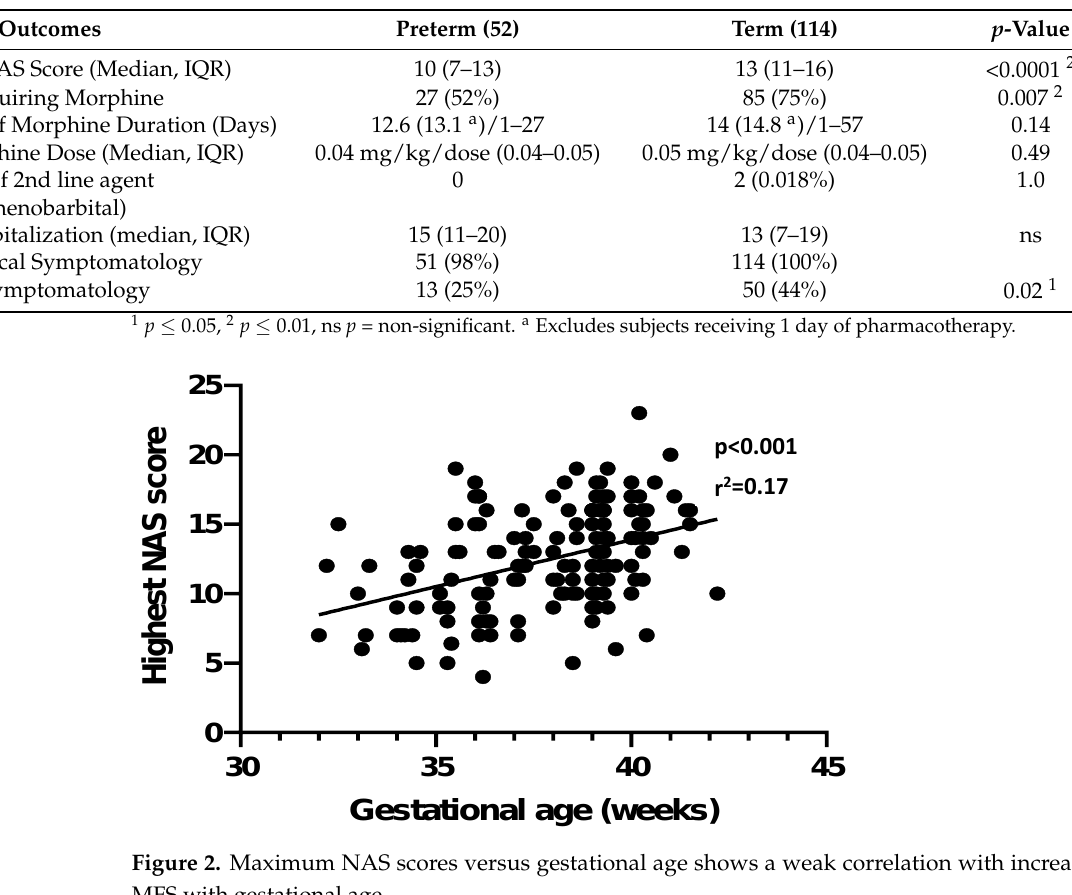
Table 3. Effect of Feeds on NAS Scores and Need for Pharmacotherapy.